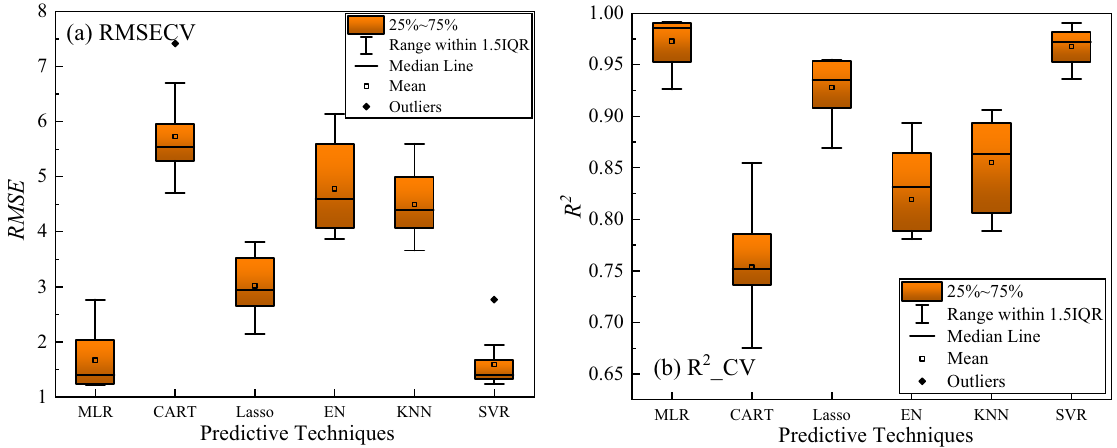
Figure 5: Box plots of ( a ) RMSECV and ( b ) R 2 _CV for six conventional